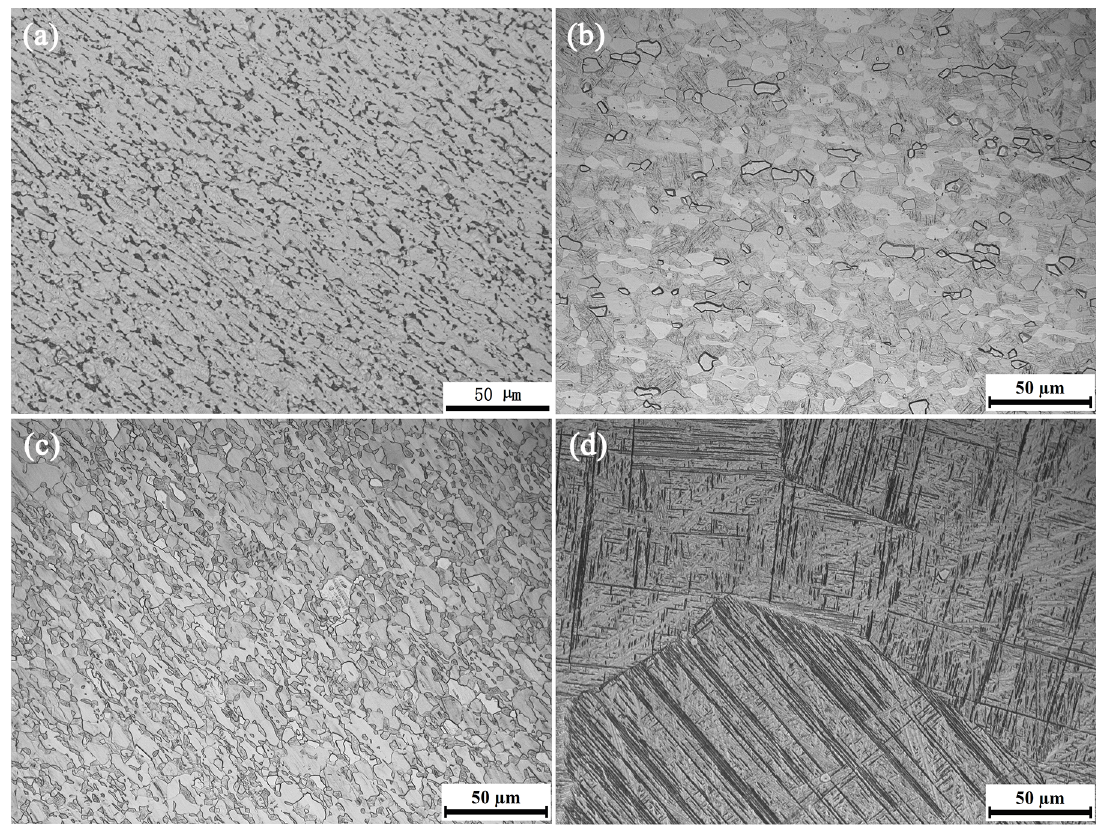
Figure 1. Microstructure of Ti-6Al-4V with different heat treatment temperature: (a) original material; (b) 850ºC/1h+WQ; (c) 900ºC/1h+WQ;(d) 950ºC/1h+WQ. Table 1. The details of the cut-off energy, the k-mesh and the crystallographic data of calculation in this work. Phase